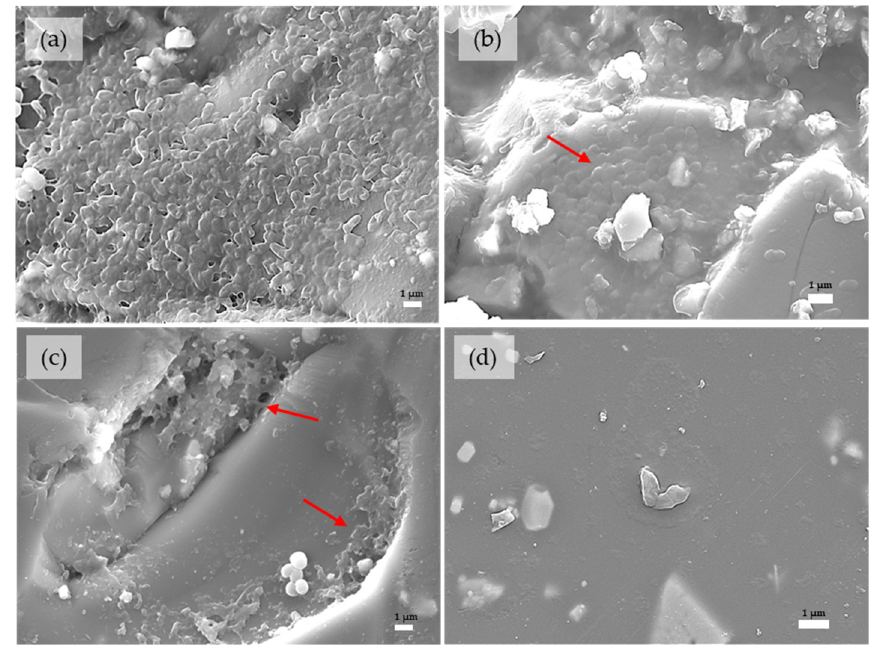
Figure 6. Representative scanning electron microscopy (SEM) micrographs of 5-day-old biofilm destruction after treatment with UV 20 s ( b ), 0.4 mg/L of Cl for 1 min ( c ), combination of UV for 20 s and Cl for 1 min ( d ); ( a ) represented untreated control biofilm. Magnifications ( a , c ) 5000×, ( b ) 1000× and ( d ) 2000×. Red arrows point out bacteria embedded in EPS.